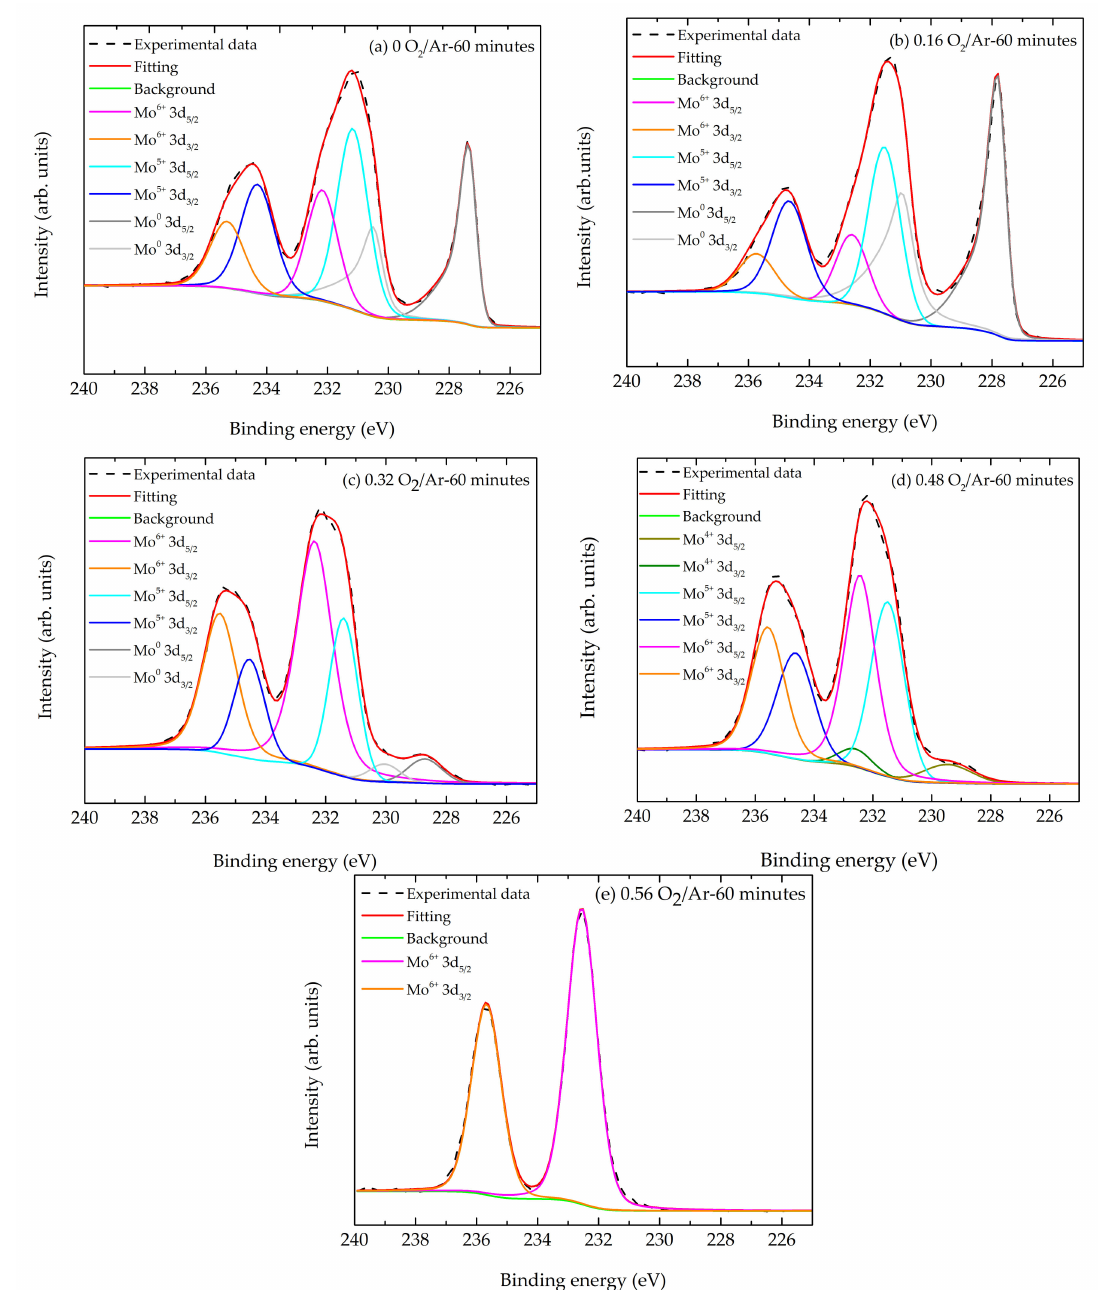
Figure 3. High-resolution XPS spectra of the Mo 3d sate showing the spin-orbit splitting. The deconvoluted peaks associated with the 3d 3/2 and 3d 5/2 orbitals are also indicated for sample ( a ) 0 O 2 /Ar-60 min, ( b ) sample 0.16 O 2 /Ar-60 min, ( c )